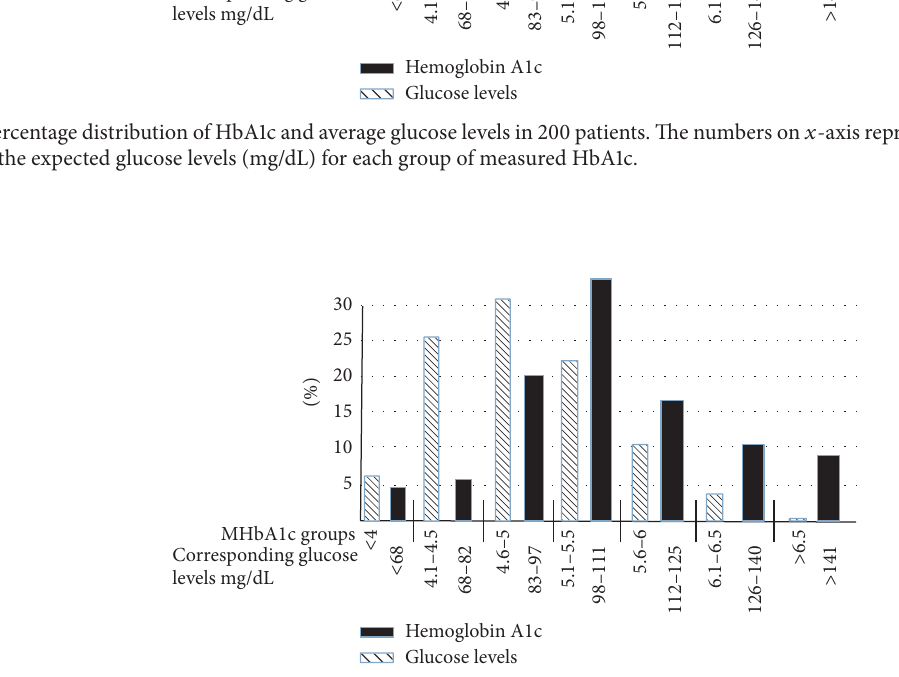
Figure 2: Percentage distribution of HbA1c and average glucose levels in 138 nondiabetic patients. The numbers on 𝑥 -axis represent the measured HbA1c groups and the expected glucose levels (mg/dL) for each group of measured HbA1c.